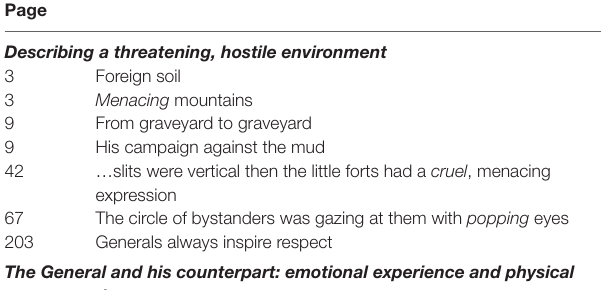
TABLE 1 | Quotes from the text